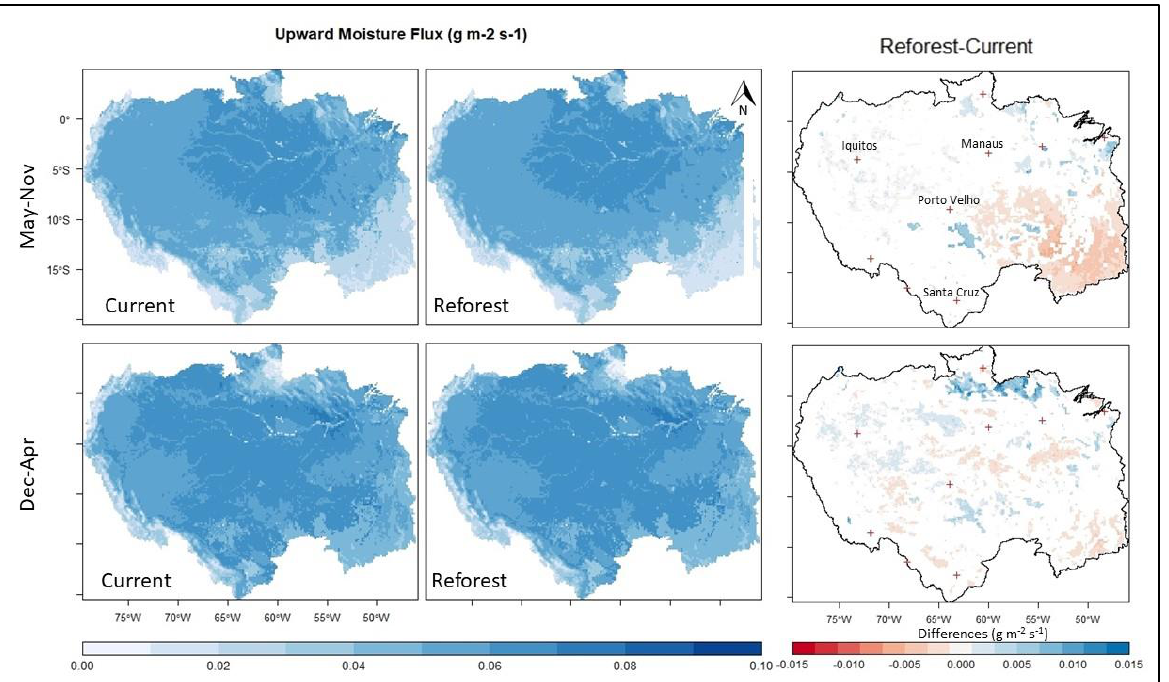
Figure 7. Simulated QFX, forced with current and reforested land cover on the left. On the right, the difference between the two simulated QFXs is at a 95% significance level. Plus signs indicate major cities.